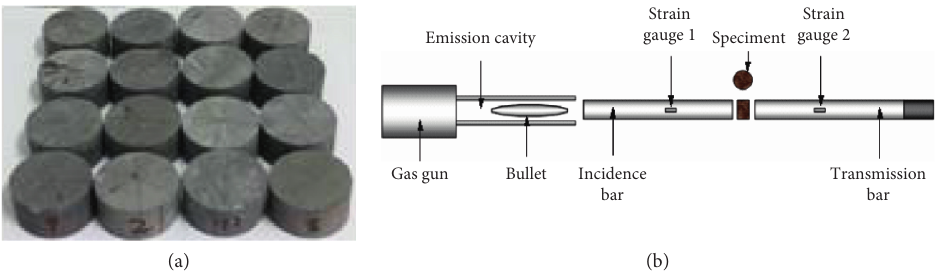
Figure 1: Rock specimens and experiment systems. (a) Part of rock specimens (b) SHPB experiment system.